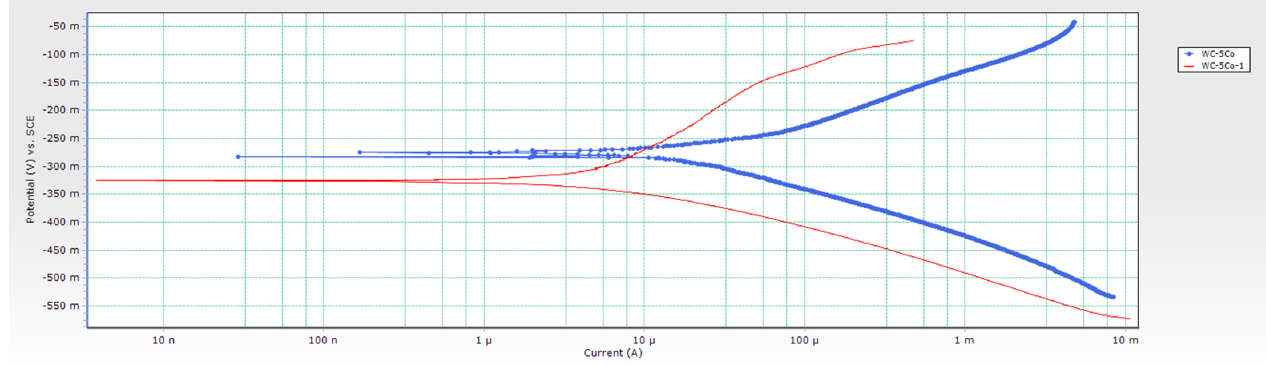
Figure 12. Tafel extrapolation curves of WC-5Co samples with different microstructural characteristics. The WC-5Co-1 sample with lower magnetic saturation value and consequently higher W and C content in the Co binder showed approximately 30% lower corrosion rate, which is in line with previous research. Sutthiruangwong and Mori found that the mag- netic saturation related to Co binder composition plays an essential role in the corrosion properties of hardmetals [15,23,24]. F.J.J. Kellner et al. found that electrochemical corro- sion resistance of hardmetals is influenced by the W and C diffusion in the Co binder amount which is increased by decreasing the WC grain size [25]. They concluded that W and C dissolved in Co binder during the sintering process stabilize the thermodynami- cally unstable FCC Co crystal structure at room temperature, the amount of which is in- creased by an increase of W and C content in the binder. FCC Co is characterized by better